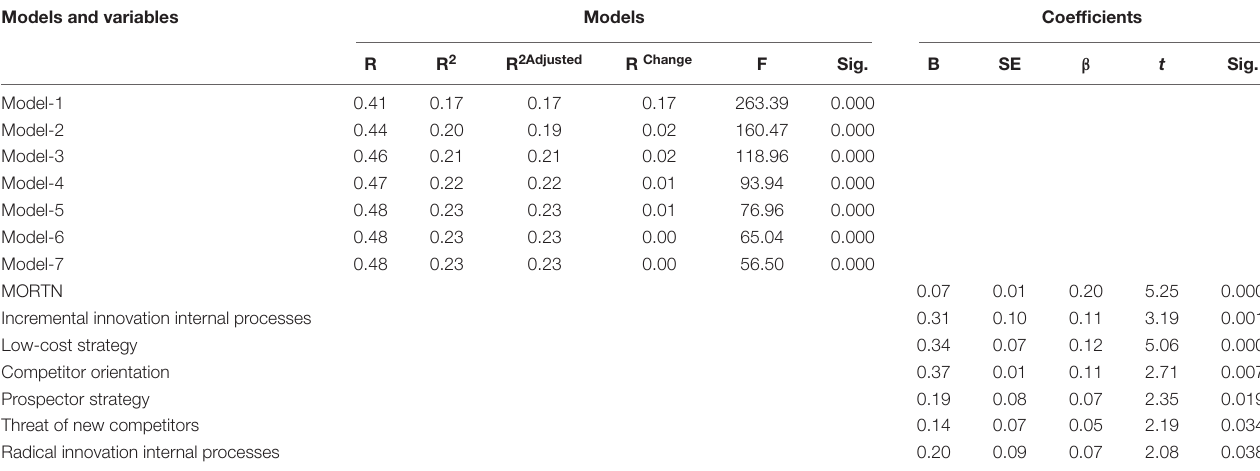
TABLE 7 | Summary of the models, predictive variables, and coefficients of regression analysis (stepwise method): hierarchy culture (Peruvian subsample n 2 = 1,317). Models and variables